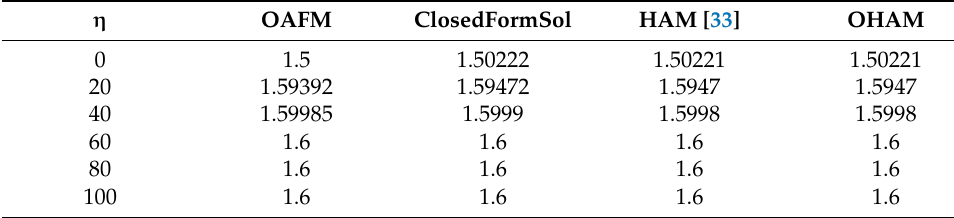
(cid:17)(cid:12) (cid:12) (cid:12)